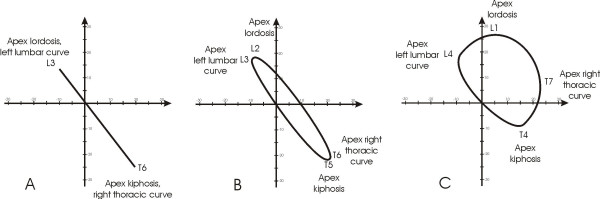
In electronic signaling, phase is an expression of relativemovements between two waves: when they have the apexes coincident they are "in phase". Looking at the curves of scoliosis in the frontal plane and kyphosis/lordosis in the sagittal, they can be imagined as waves: by analogy, we called the relationship between these two "waves", one physiological, the other pathological, Phase, because it takes into account the reciprocal relationship (localization and morphology) among them. In this Figure three different clinical situations in which the classical radiographic curves can be defined "in phase" (isophasic) or not "in phase" (anisophasic) have been simulated. In these hypothetical clinical cases all scoliosis curves have an amplitude of 30° Cobb and all sagittal curves of 40°. A. Isophasic scoliosis: double frontal curve with identical apex vertebrae in the frontal and sagittal planes; the right thoracic curve and kyphosis have both the apex in T6, while the left lumbar and lordosis in L3. B. First anisophasic scoliosis: double frontal curve with a slight difference between the apex vertebrae in the frontal and sagittal planes; the right thoracic curve has the apex in T6 while kyphosis in T5, the left lumbar in L3 and lordosis in L2. C. Second anisophasic scoliosis: double frontal curve with an important difference between the apex vertebrae in the frontal and sagittal planes; the right thoracic curve has the apex in T7 while kyphosis in T4, the left lumbar in L4 and lordosis in L1.